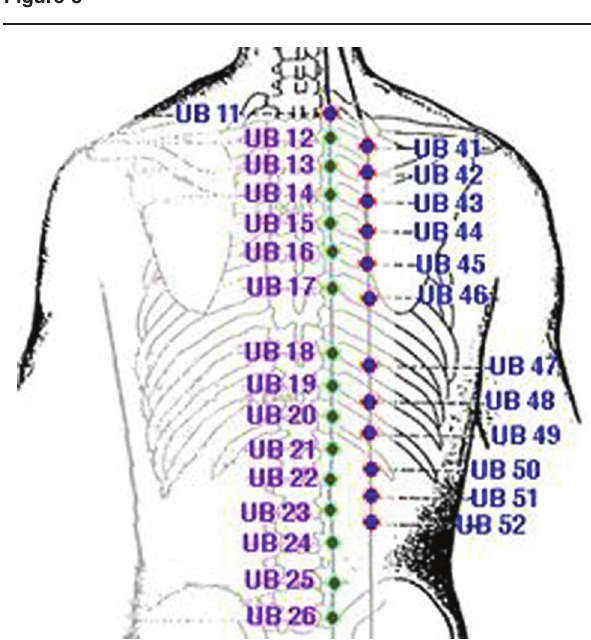
Urinary bladder meridians. Image courtesy of all-about-acupuncture. com.